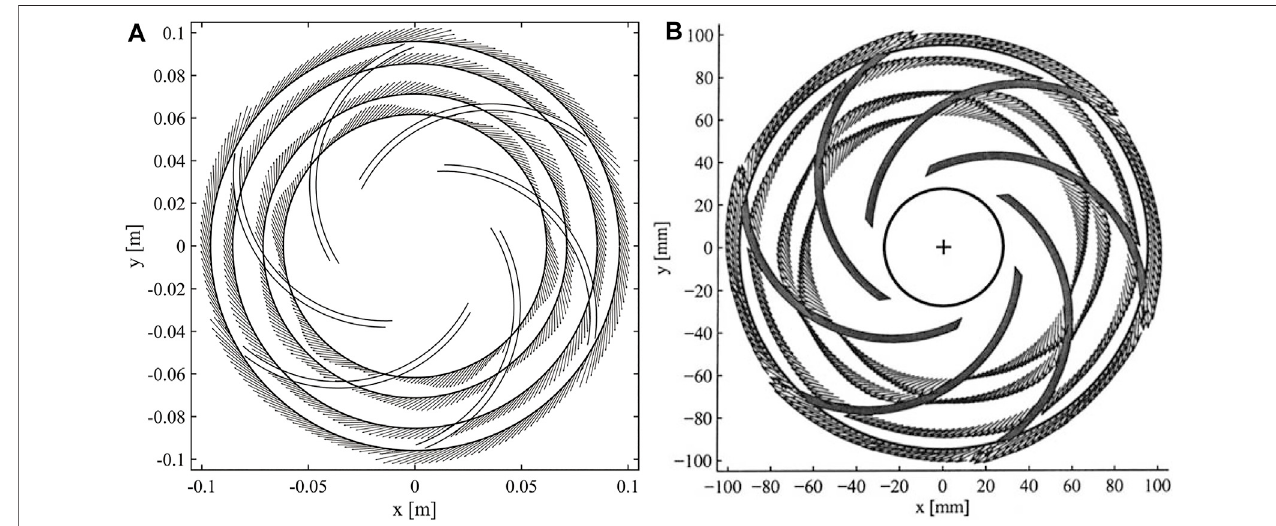
FIGURE 11 | Velocity vector distributions at different radial positions under the design-load condition: (A) PANS and (B) LDV.